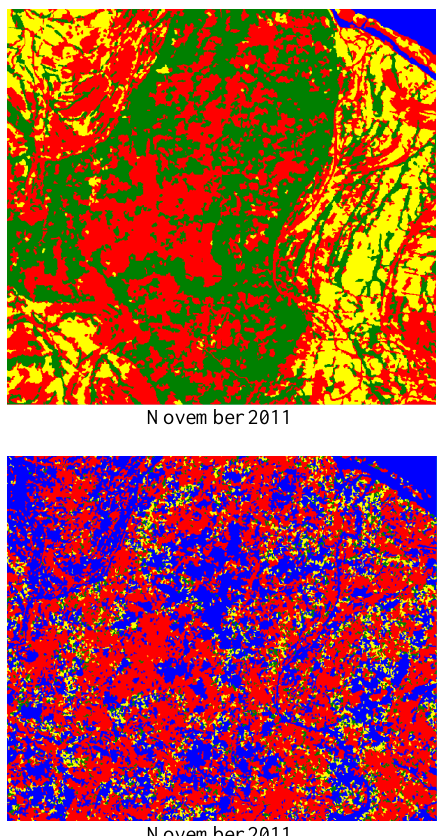
Figure 3: Top: ETM+ Image RGB= bands 5,4,3 from November 2011; Bottom: ENVISAT ASAR APS HV processed data from November 2011 A maximum likelihood classifier was used in ENVI to compare the ETM+ image alone, a minimum distance classifier was used for the single band SAR image, and the two images fused together. The results are shown in Figure 4 below.